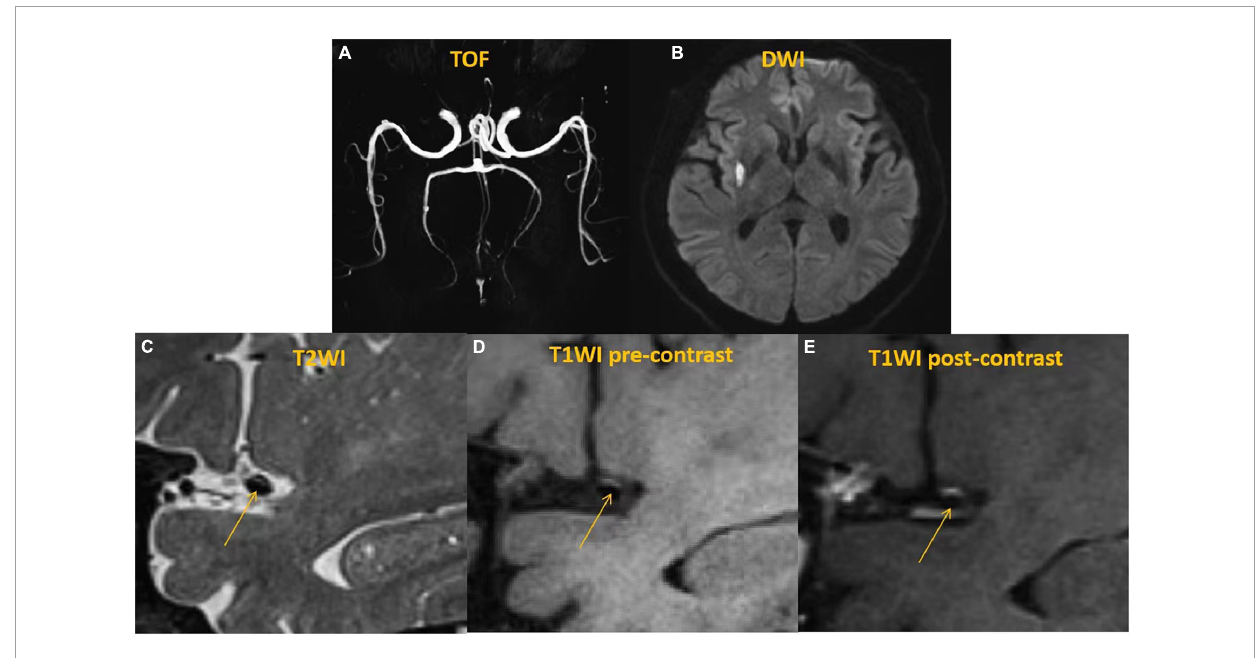
FIGURE1 A 59 years-old man with acute ischemic stroke in the right basal ganglia. Time-of-flight (TOF)-magnetic resonance angiography (MRA) (A) demonstrated the stenosis located on the right middle cerebral artery (MCA). Diffusion weighted imaging (DWI) (B) showed a sheet acute infarcts in the right basal ganglia. High-resolution vessel wall MRI (hr-vw MRI) including T2-weighted image (C) , pre-contrast T1-weighted image (D) and post-contrast T1-weighted image (E) visualized the plaque on the superior side of the right MCA. The plaque showed isointense to hyperintense on T2-weighted image (C) and pre-contrast T1-weighted image (D) and moderate enhancement on post-contrast T1-weighted image (E) .